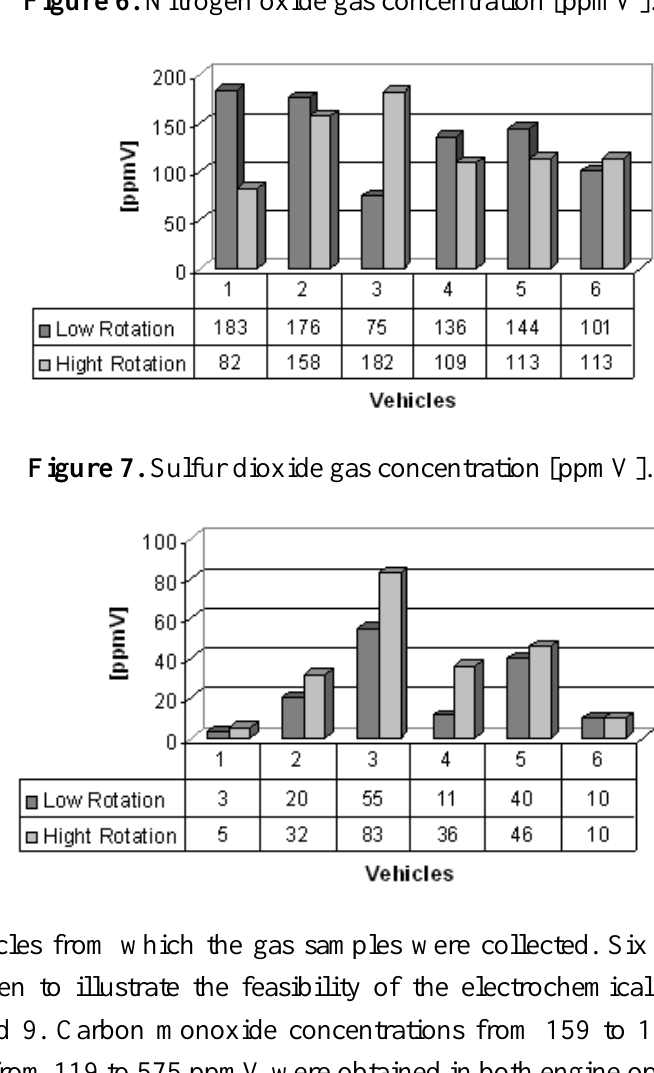
Figure 6. Nitrogen oxide gas concentration [ppmV].